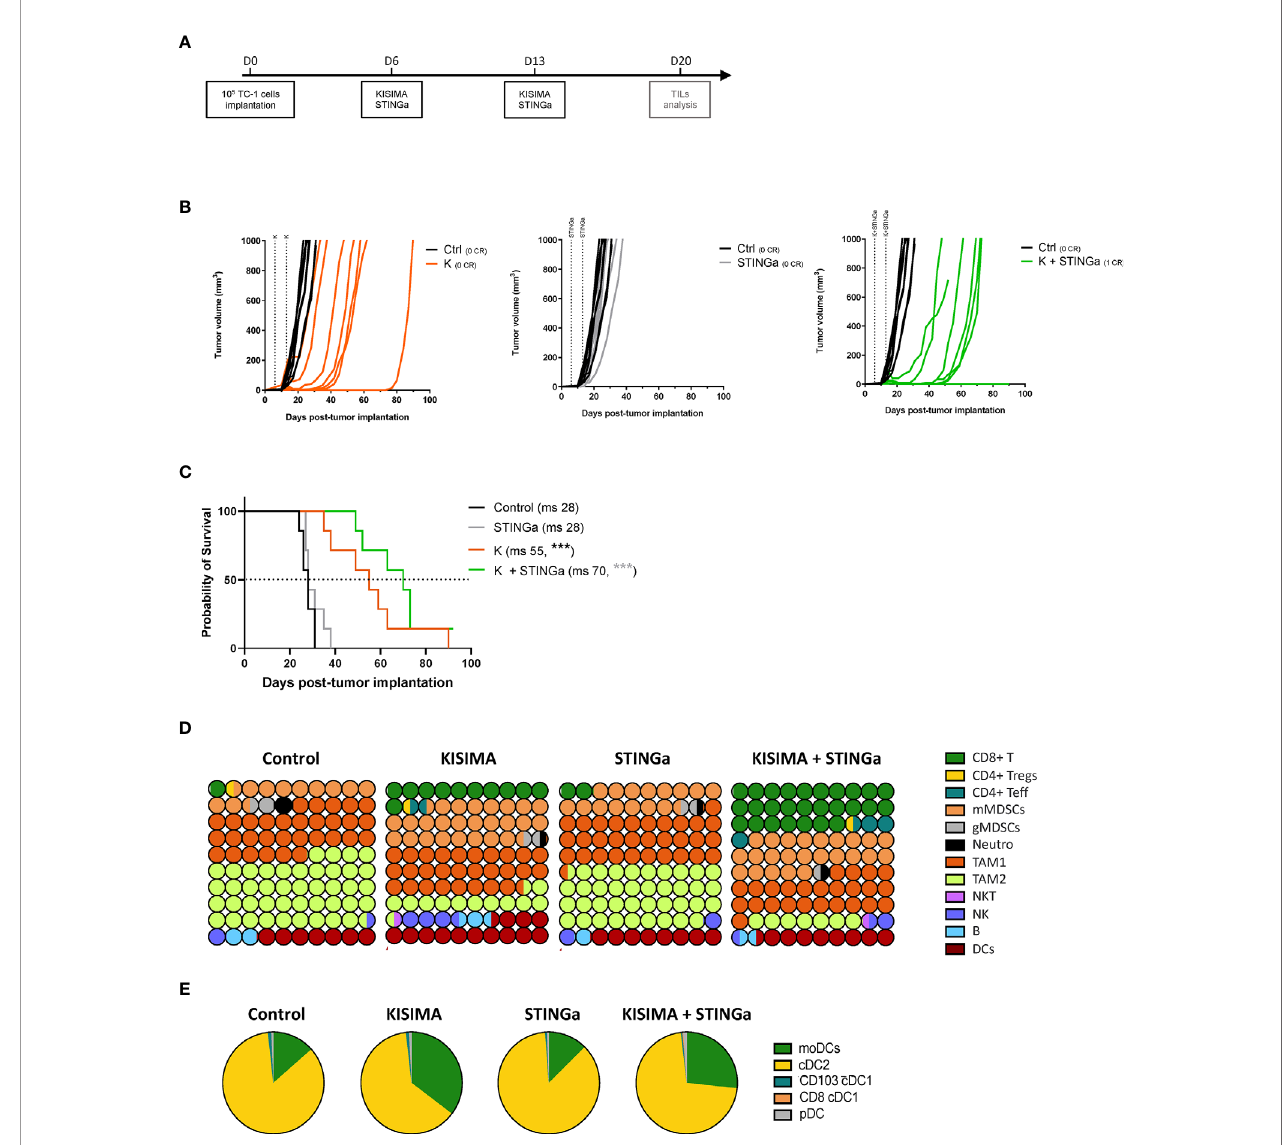
FIGURE 3 | Combining protein vaccine with STING agonist delays TC-1 tumor growth and profoundly impacts tumor microenvironment. 10 5 TC-1 cells were implanted subcutaneously on the back of C57BL/6 mice. When tumors were visible, mice were treated with two administrations of KISIMA vaccine, STING agonist or a combination of the two at one-week interval and tumor growth was monitored. (A) Vaccination schedule. Tumor growth (B) and median survival (C) were followed. CR, complete regression; ms, median survival. (D) 10 × 10 dot plot chart showing 100 circles, corresponding to 100%, and representing the proportion of different cell populations among CD45+ tumor-in fi ltrating cells; every circle represents 1% of the CD45+ population (see Figure S11 for gating strategy). (B) Pie chart representing different tumor in fi ltrating dendritic cell populations, moDCs (CD11b + MHCII hi CD11c hi Ly6C + ), cDC2 (CD11b + MHCII hi CD11c hi Ly6C + CD103 − ), cDC1 (CD11b-MHCII hi CD11c hi CD24 + and CD103 + or CD8 + ), pDC (CD11b - Ly6C + CD11c int B220 + PDCA1 + ). One representative of three experiments (n = 7/group/replicate) (B, C) or a pool of two experiments (n = 7/group) (D, E) are shown. Log-rank Mantel – Cox test , ***p <